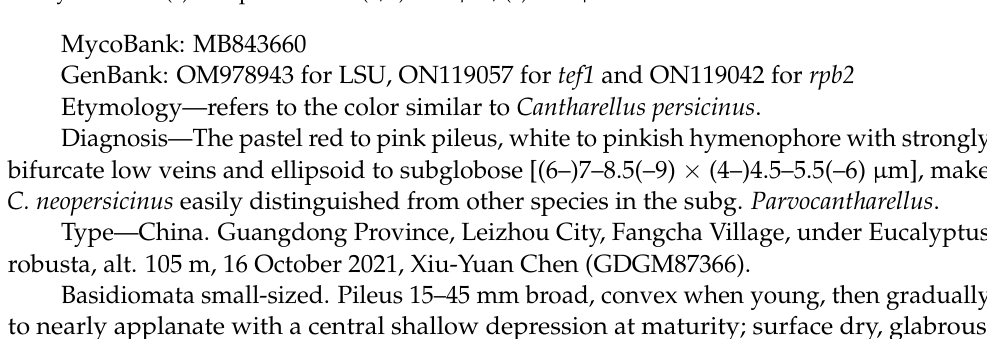
Figure 15. Cantharellus neopersicinus . ( a ) Basidiospores. ( b ) Basidia, basidiola and elements of the subhymenium. ( c ) Pileipellis. Bars: ( a , b ) = 10 μ m; ( c ) = 20 μ m.